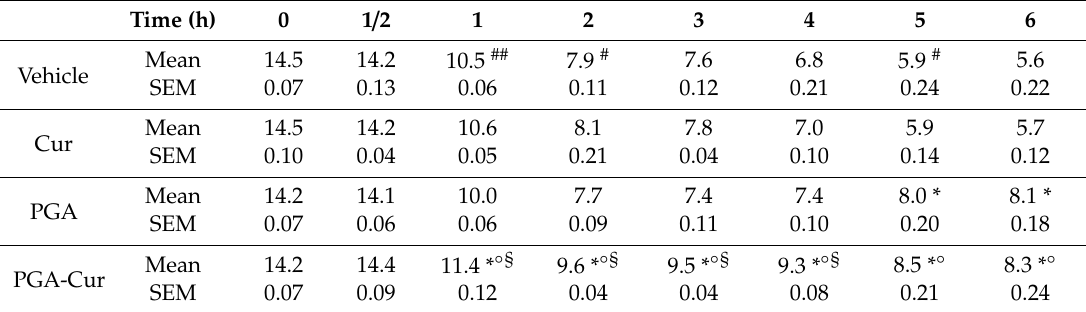
Table 1. The e ff ect of PGA and curcumin (Cur) given individually or in a co-micronized formulation (PGA-Cur) on inflammatory pain measured as thermal hyperalgesia. Data (mean and standard error of the mean (SEM), N = 6 / group) are expressed as paw withdrawal latency change (in seconds) at the consecutive time points. The less was the latency the more severe the hyperalgesia. Time (h) 0 1 / 2 1 Mean Vehicle